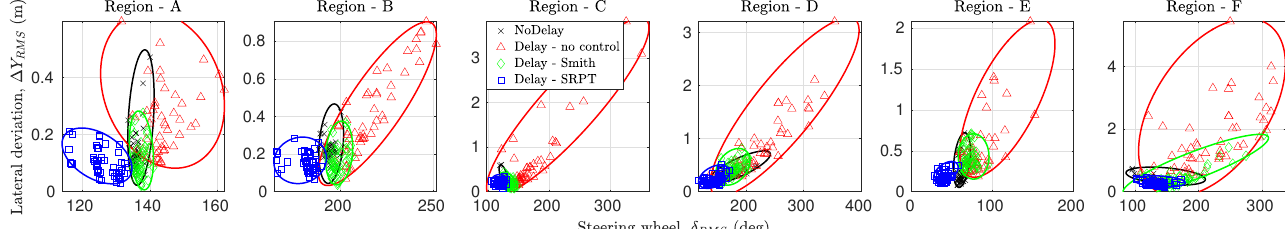
Figure 14. Scenario 1: Lateral deviation from the center line vs. steer by human at control station. Red points which represent ‘Delay + no control’ mode show poor performance. This